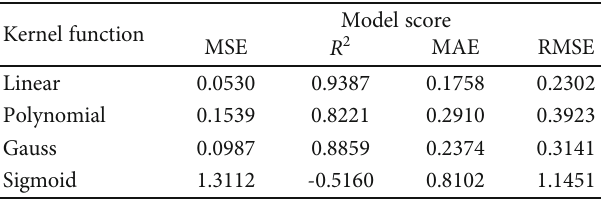
Table 7: SVR+RF model score.